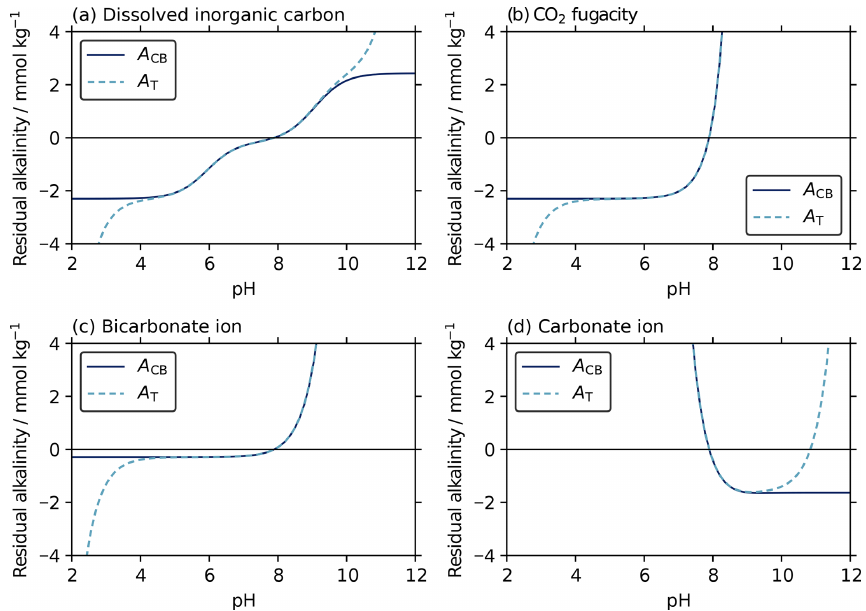
Figure 6. Residuals between known A T (2.3mmolkg − 1 ) and (i) carbonate–borate alkalinity (solid lines; A CB ) from Eqs. (F1), (4), (11), and (17), as well as (ii) total alkalinity (dashed lines; A T ) from Eq. (B1), calculated across a range of pH, with a second known parameter of (a) dissolved inorganic carbon (2.15mmolkg − 1 ), (b) CO 2 fugacity (600µatm), (c) bicarbonate ion content (2011µmolkg − 1 ), and (d) car- bonate ion content (116µmolkg − 1 ), all at a salinity of 35 and temperature of 15 ◦ C. Each possible pH value returns a different residual alkalinity, and the true pH root is where the residual alkalinity is zero. Both the initial estimates and the final solutions find this zero-residual pH root using the A CB and A T equations, respectively (Sect. 3.1.1 and 3.2). The similarity between the A CB and A T residual curves, partic- ularly around zero residual alkalinity, shows that the initial estimates provide excellent starting values for the subsequent iterative solvers. In (d) , the final iterative solver has two possible roots, where residual alkalinity is zero. However, the initial estimate has only one root, corre- sponding to the lower-pH final root. This ensures that the final solver will always converge to the lower-pH root, which is usually appropriate for the seawater